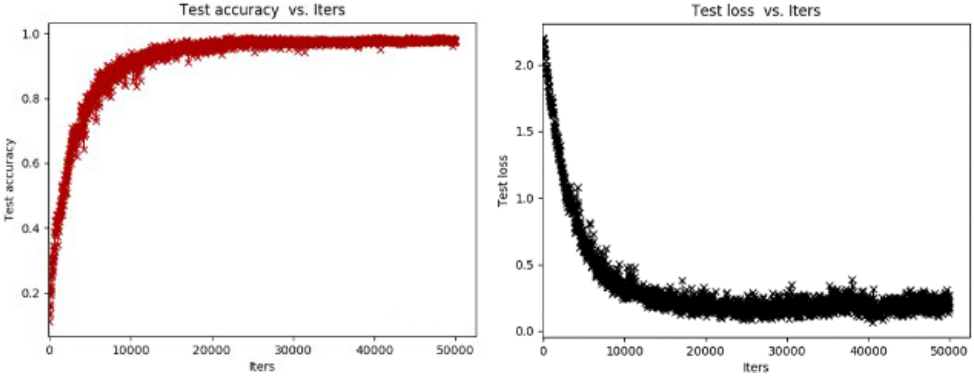
Fig. 11 The training and testing results of GoogLeNet model.